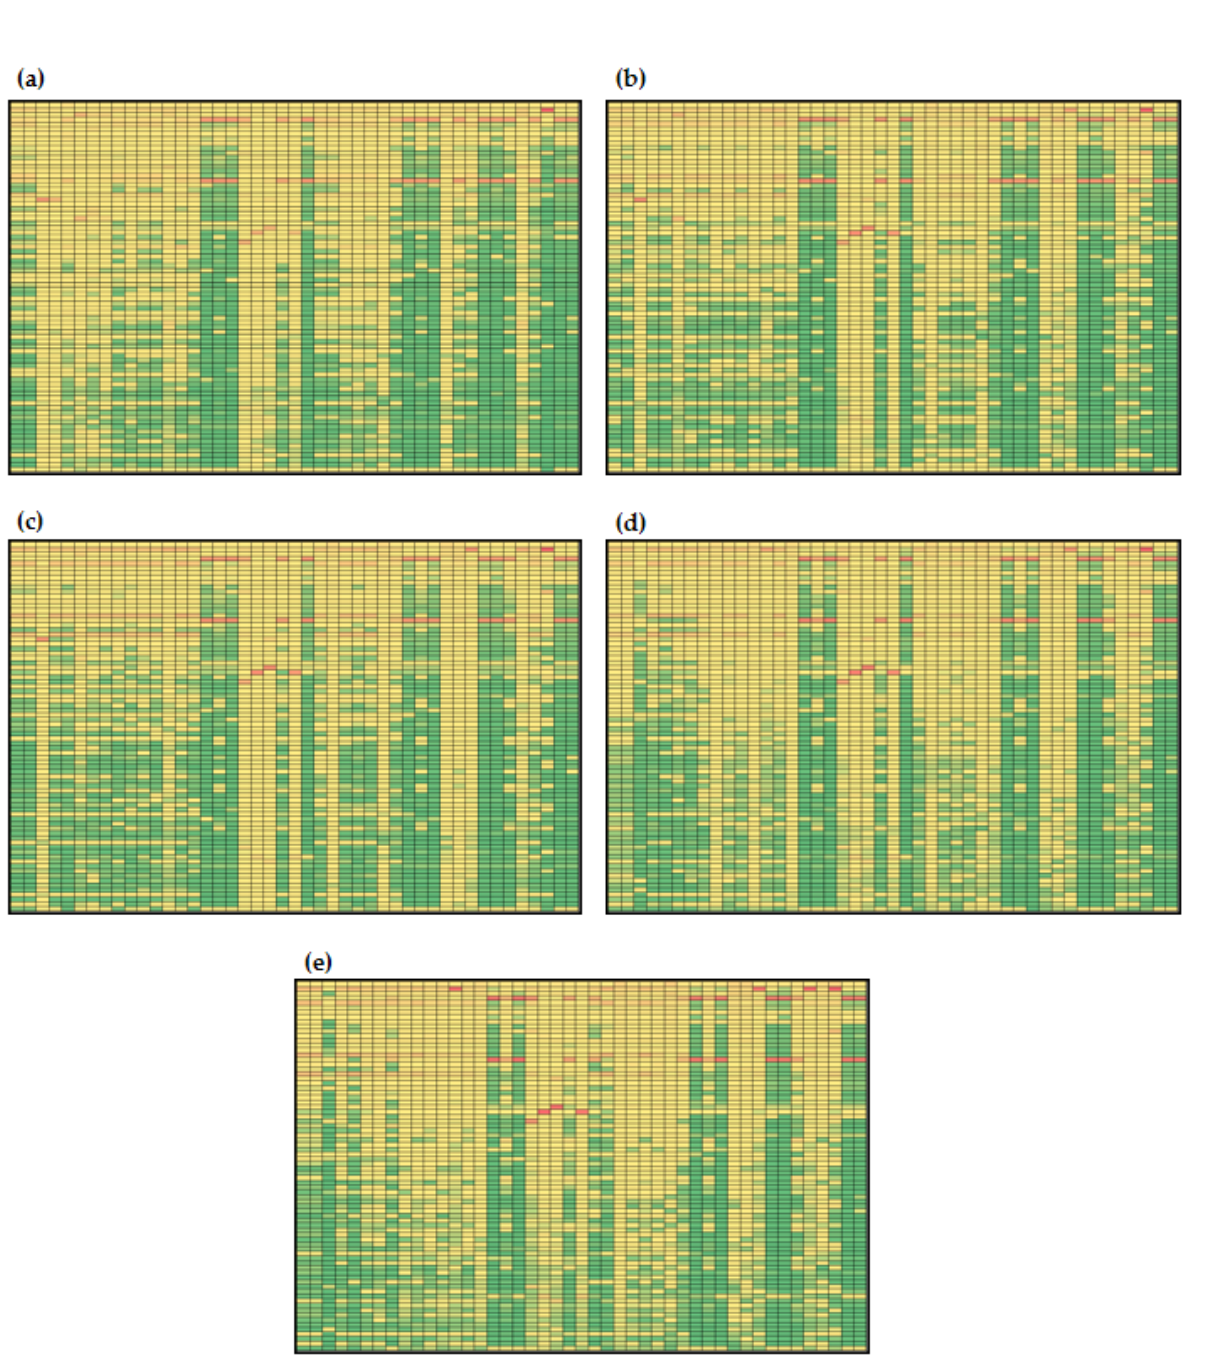
Figure 8. Global sensitivities of hepatic lipid model reactions (initial conditions for simulations according to Menu 2): ( a ) t f = 10 min, ( b ) t f = 50 min, ( c ) t f = 100 min, ( d ) t f = 250 min, ( e ) t f = 500 min. Rows: β G , β 6 , β f , β l , β m , µ AMP , µ e , µ s , µ 1 , µ 2 , µ 3 , µ 4 , c 0 , c c , d BA , k 10 , k 11 , k 12 , k 13 , k 14 , k 22 , k 5 , k 6 , k 6l , k 6p , k 7 , k 8 , k 9 , k 9a , k a , k aa , k ai , k al , k ba , k bl , k bm , k cl , k cm , k d , k dl , k dy , k ft , k ga , k gi , k gl , k gl2 , k gm , k gm2 , k gp , k lp , k LG , k LH , k MH , k na , k p , k p6 , k pp , k r , k re , k t , k yl , k ym , l max , m max , v min , v 10, v 12 , v 6 , v 8 , v 9 , v LG , v LH , v MH , y 0 , α G , α F , m s , m e . Columns: I , G L , Y L , P L , R L , A L , S L , T L , G M , Y M , P M , R M , A M , T M , P , T A , A A , L A , G A , T CB , A NB , T LB , G B . The global sensitivity coefficients are marked with colors: green indicating low values of sensitivity coefficients, and red indicating high values of global sensitivity coefficients based on the data distribution at the percentile